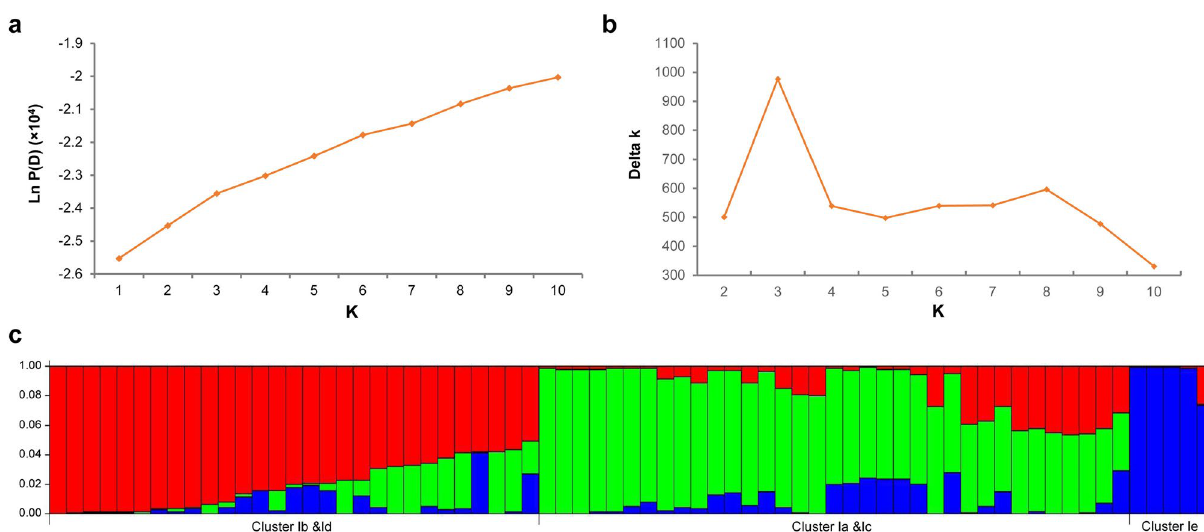
Figure 6. Structure analysis of 69 C. japonica accessions. ( a ) Estimated LnP(D) of possible clusters (K) from 1 to 10. ( b ) ΔK based on the rate of change of LnP(D) between successive K. ( c ) Population structure of 69 C. japonica accessions. Labels below refer to the cluster number in NJ